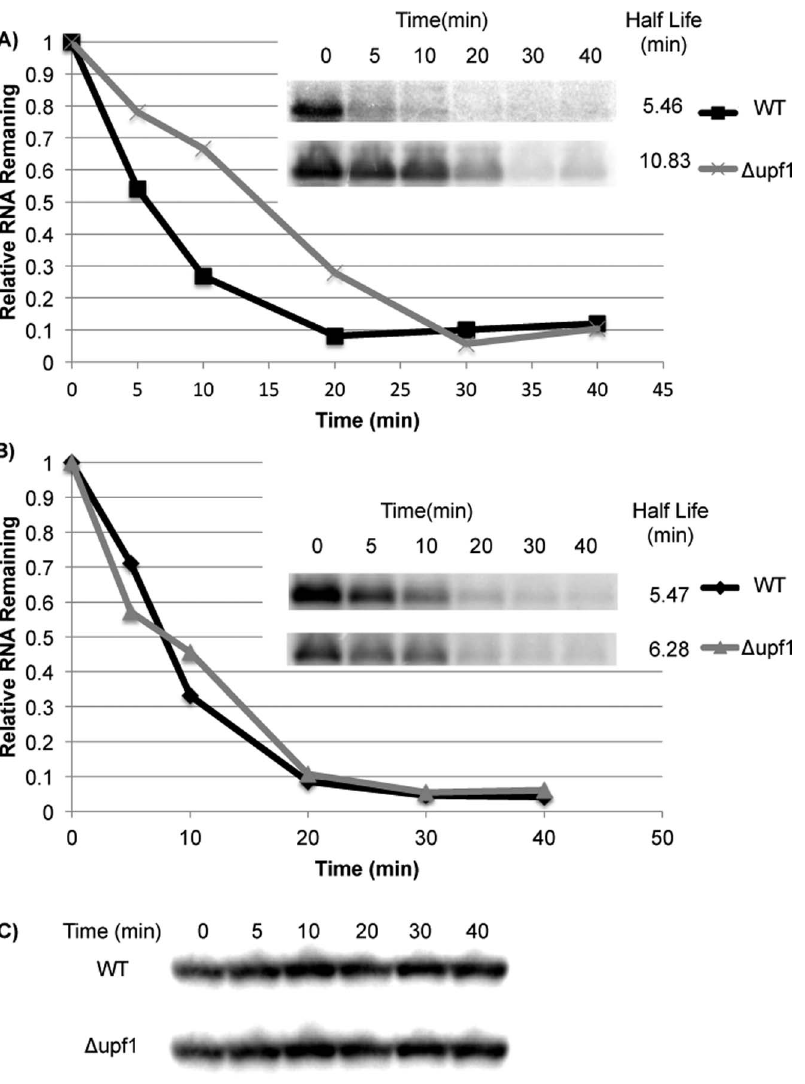
Figure 3. The long transcript from GFP-MSH4-3 9 UTR shows increased stability in NMD-deficient strains. Representative half-life measurements in a W303A background are shown for both ( A ) the longer transcript product and ( B ) the shorter transcript product. Inlay depicts the sample being represented in the graph and is adjacent to the corresponding marker. Only the longer transcript shows increased stability in an NMD deficient strain when transcription is inhibited by the addition of